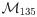
Model M135 predictions and fits to target mRNA data (fold changes) for the Gln+Rap shift.Panel description is identical to Fig 6.